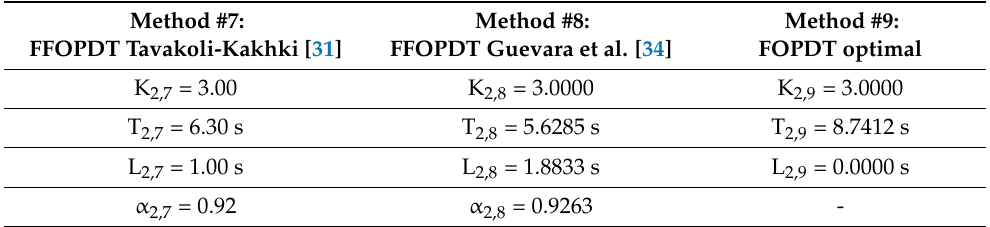
Table 18. FFOPDT model parameters obtained using methods proposed by Tavakoli-Kakhki [31] and by Guevara et al. [34], and optimal FOPDT model parameters, respectively, for process P 2